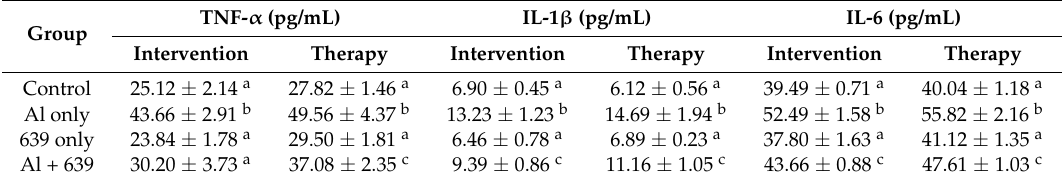
Table 2. The effects of L. plantarum CCFM639 on Al ‐ induced alterations of pro ‐ inflammatory cytokines in HT ‐ 29 cells.